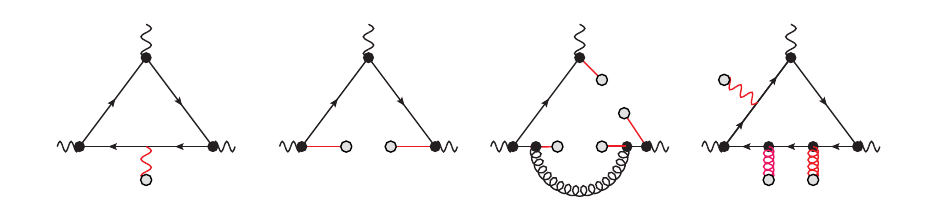
Figure 3. Topologies giving the di ↵ erent contributions to the studied